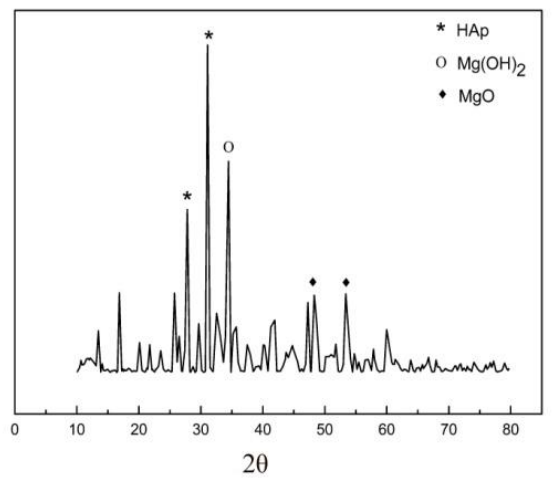
Figure 5. XRD of as-prepared Mg-HA.